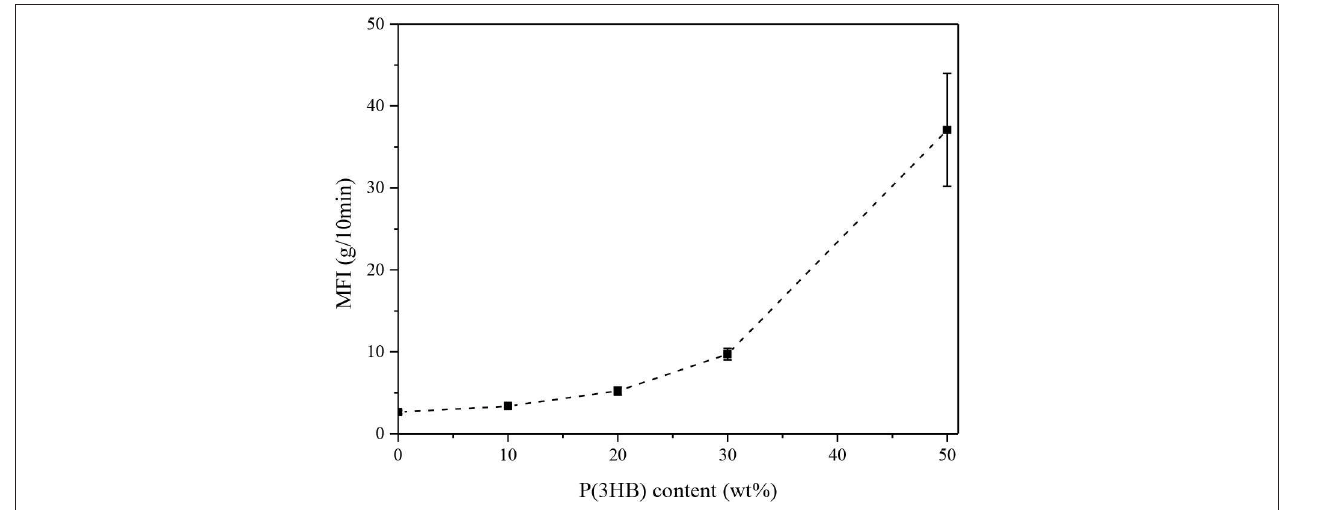
FIGURE 1 | MFI values of neat LLDPE and LLDPE/P3HB blends (T = 180 ◦ C, load = 2.16kg). Error bars represent the standard deviation.